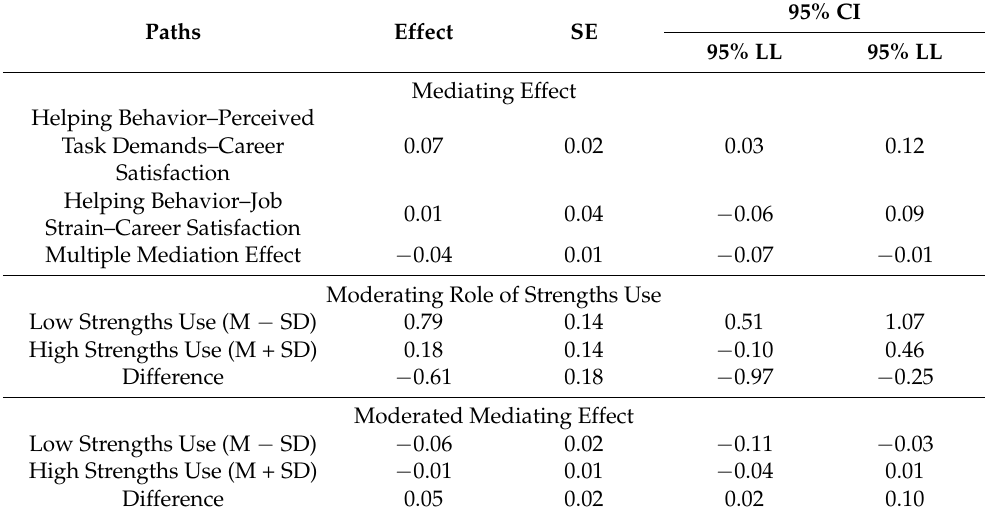
Table 3. Results of bootstrapping